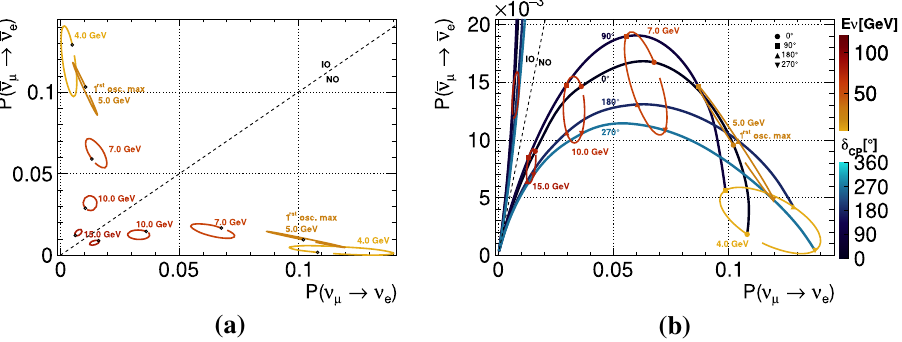
Fig. 7 a Probability for ¯ ν μ to oscillate to ¯ ν e versus the probability for ν μ to oscillate to ν e . For each neutrino energy, the two probabilities describeanellipseas δ CP isvaried.Theblackcirclesindicatesthepoints for which δ CP equals 0 ◦ . The color of the ellipses corresponds to the neutrino energy and is reported on the red color scale in b . The ellipses obtainedassumingnormalordering(NO)andinvertedordering(IO)are clearly separated with IO above the P (ν μ → ν e ) = P ( ¯ ν μ → ¯ ν e ) line